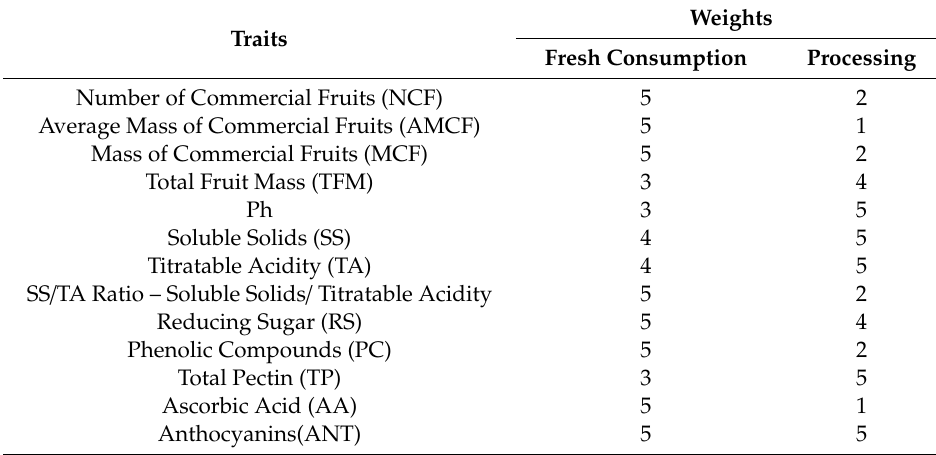
Table 1. Weights to Mulamba and Mock selection index in Fragaria × ananassa Duchesne ex Rozierfor the traits:number of commercial fruits (NCF), average mass of commercial fruits (AMCF, in g / fruit), mass of commercial fruits (MCF, in g / plant), total fruit mass (TFM, in g / plant), soluble solids (SS,